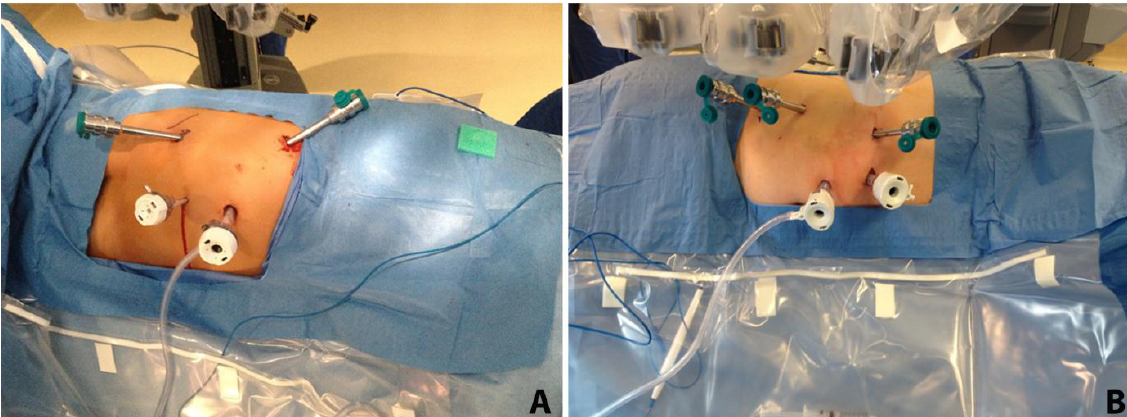
Figure 1. A, configuration of ports for a left RAPN with use of three robotic arms; B, configuration of ports for a right RAPN with use of four robotic